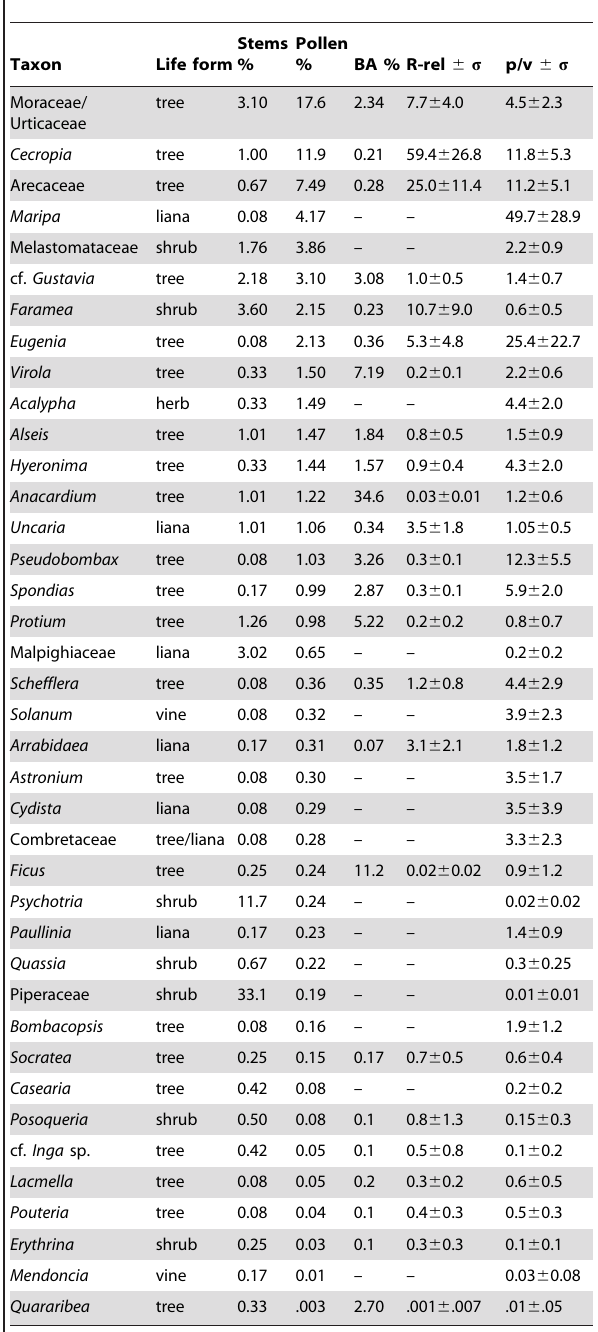
Table 1. Representation of pollen taxa with parent plants in the surrounding